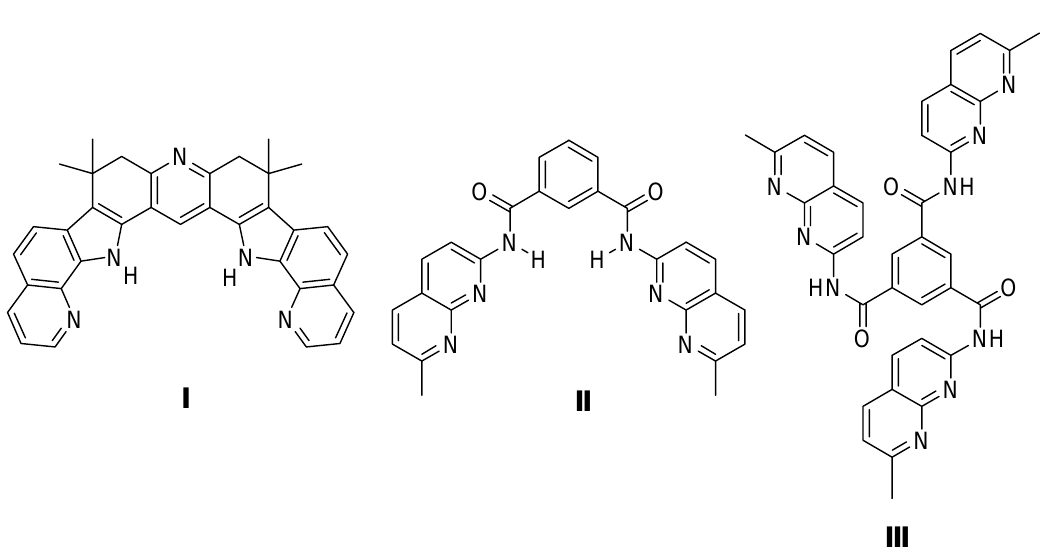
Figure 1. Receptors I – III